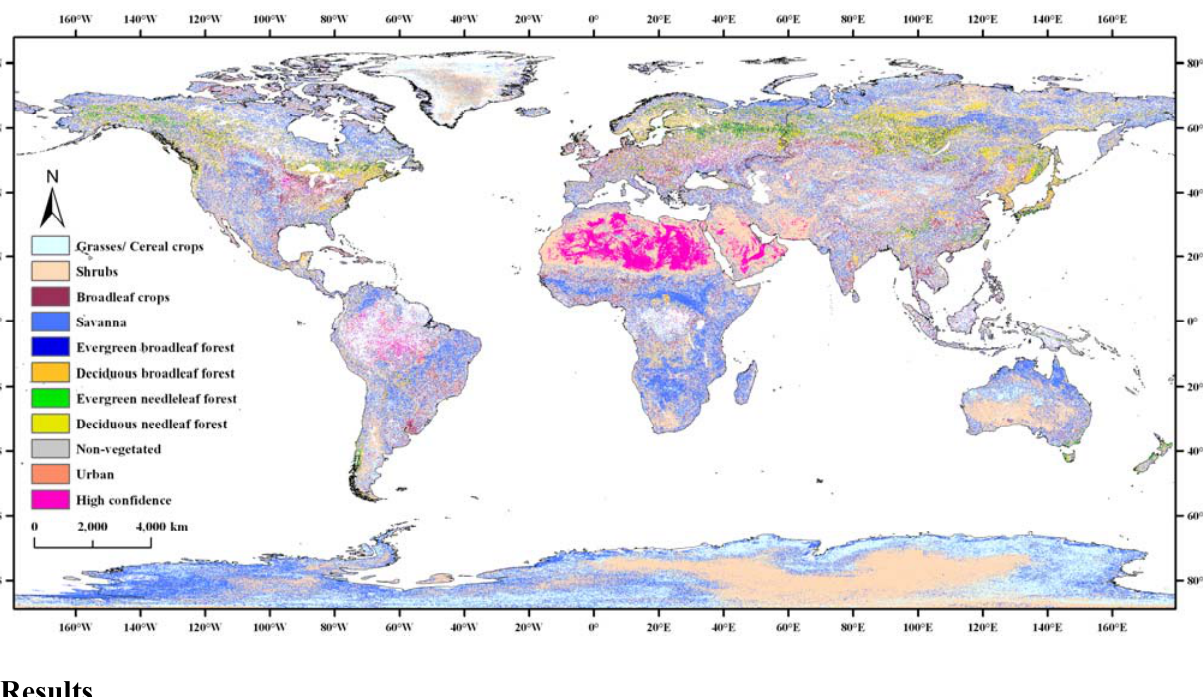
Figure 2. Global distribution of the secondary biome types based on the MODIS LAI/FPAR (Type 3) classification system. Data converted from the MODIS (MCD12Q1 C5) International Geosphere Biosphere Program (IGBP) (Type 1) classification system (1 km, 2003). Pink pixels show the primary biome types with high confidence. White areas are IGBP classes (e.g., mixed forest) with no equivalent MODIS LAI/FPAR